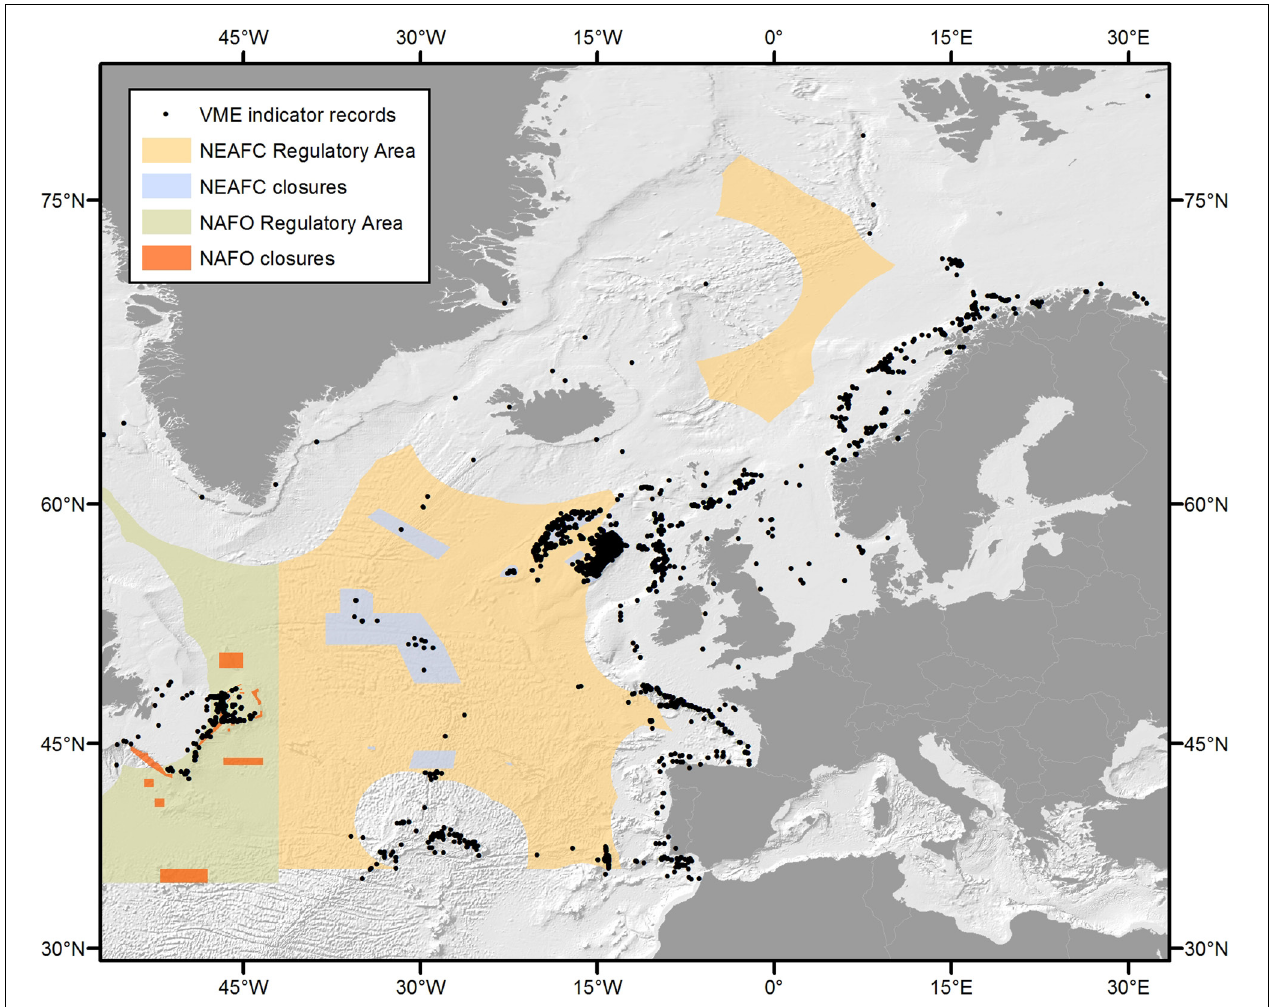
FIGURE 1 | The distribution of VME indicator records throughout the North Atlantic contained within the ICES VME database (ICES,